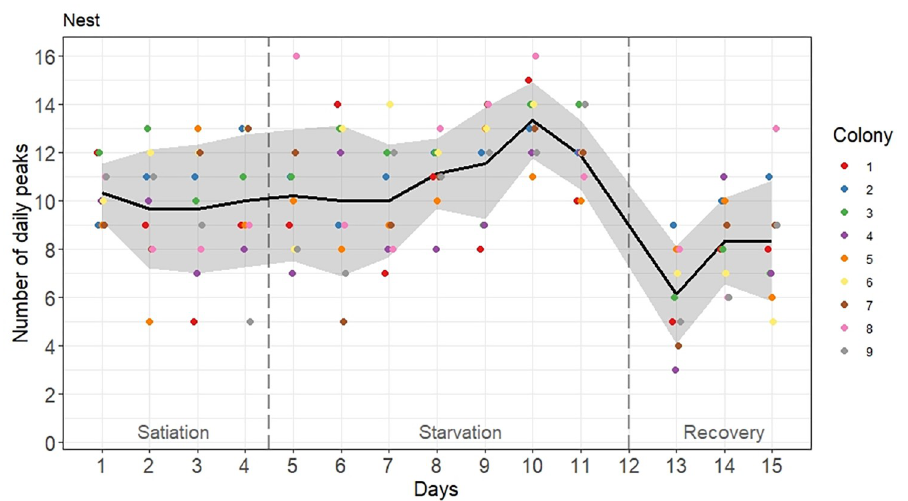
Fig 6. Time evolution of the number of activity peaks inside the nest over 15 experimental days. Colored points are the daily peaks measured for each of the nine tested colonies. They are slightly shifted on the x-axis for readability reasons. The black line and the grey area are respectively the average value and the standard deviation calculated on the daily peaks of the nine colonies. Food was removed on day 5 and was given back on day 12. Vertical dashed lines separate each experimental